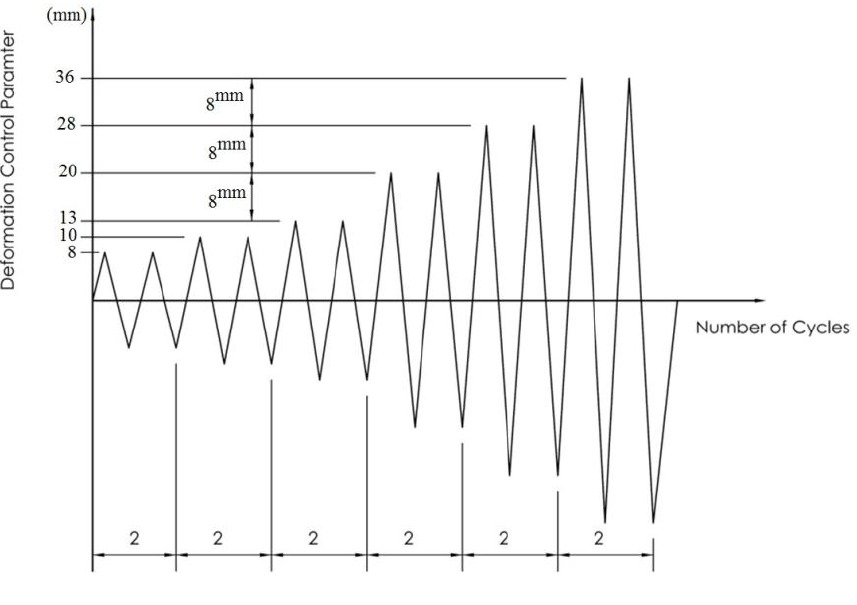
Figure 11. Quasi-static cyclic loading